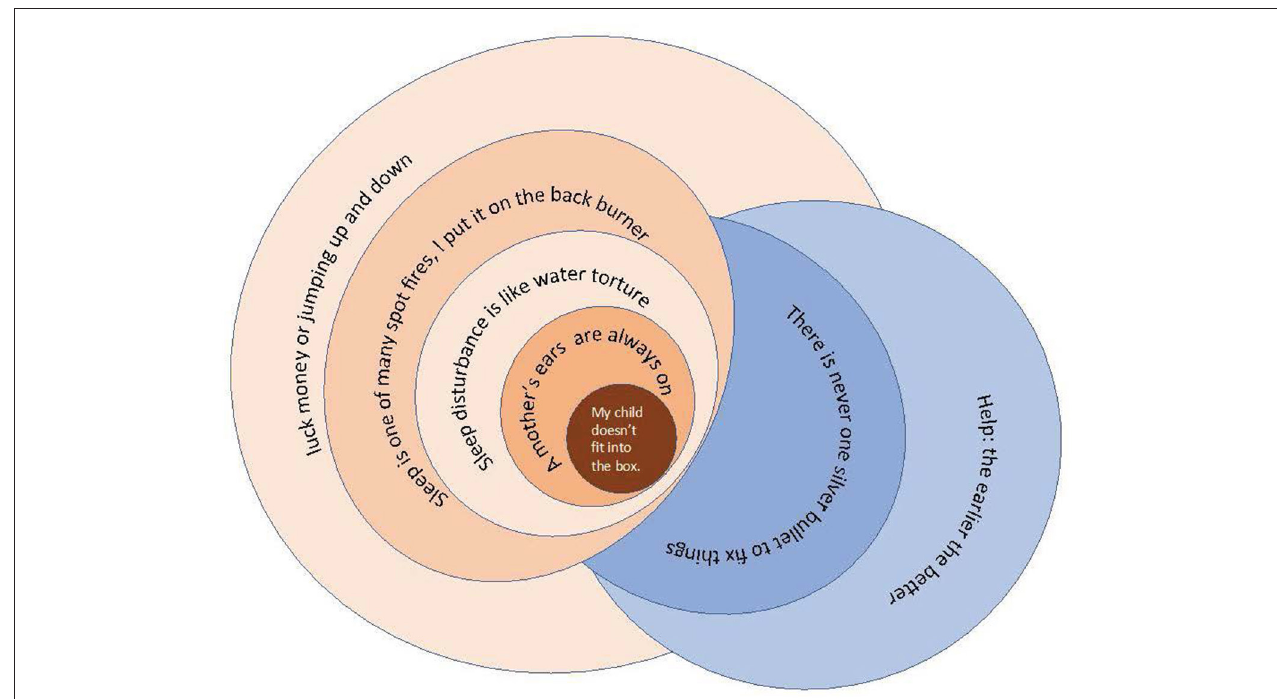
FIGURE 1 | Concept map of the thematic